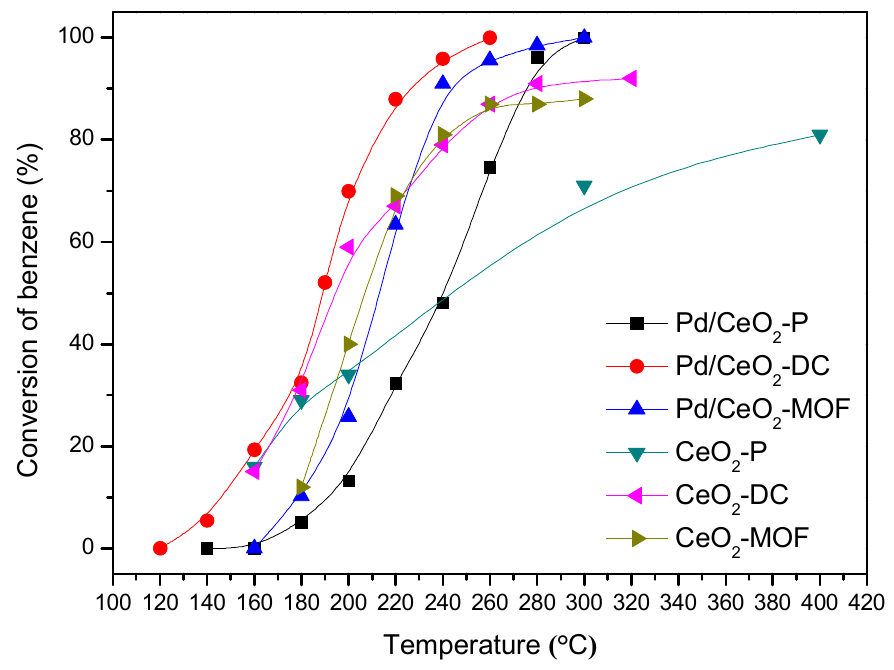
Figure 1. E ff ect of di ff erent CeO 2 and Pd / CeO 2 on catalytic combustion of Figure 1. Effect of different CeO 2 and Pd/CeO 2 on catalytic combustion of benzene.